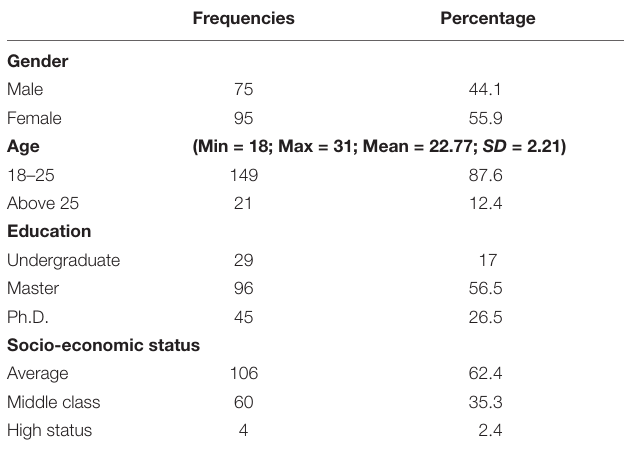
TABLE 1 | Demographic characteristics of the